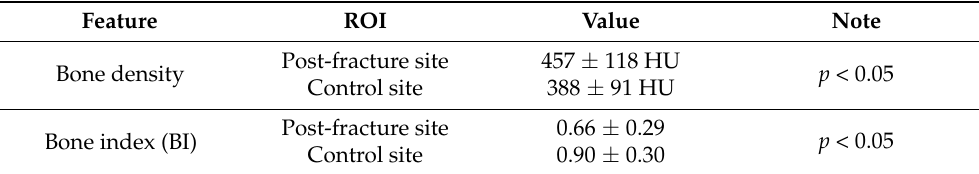
Table 2. Evaluation of bone union quality after twelve months of healing and remodeling.